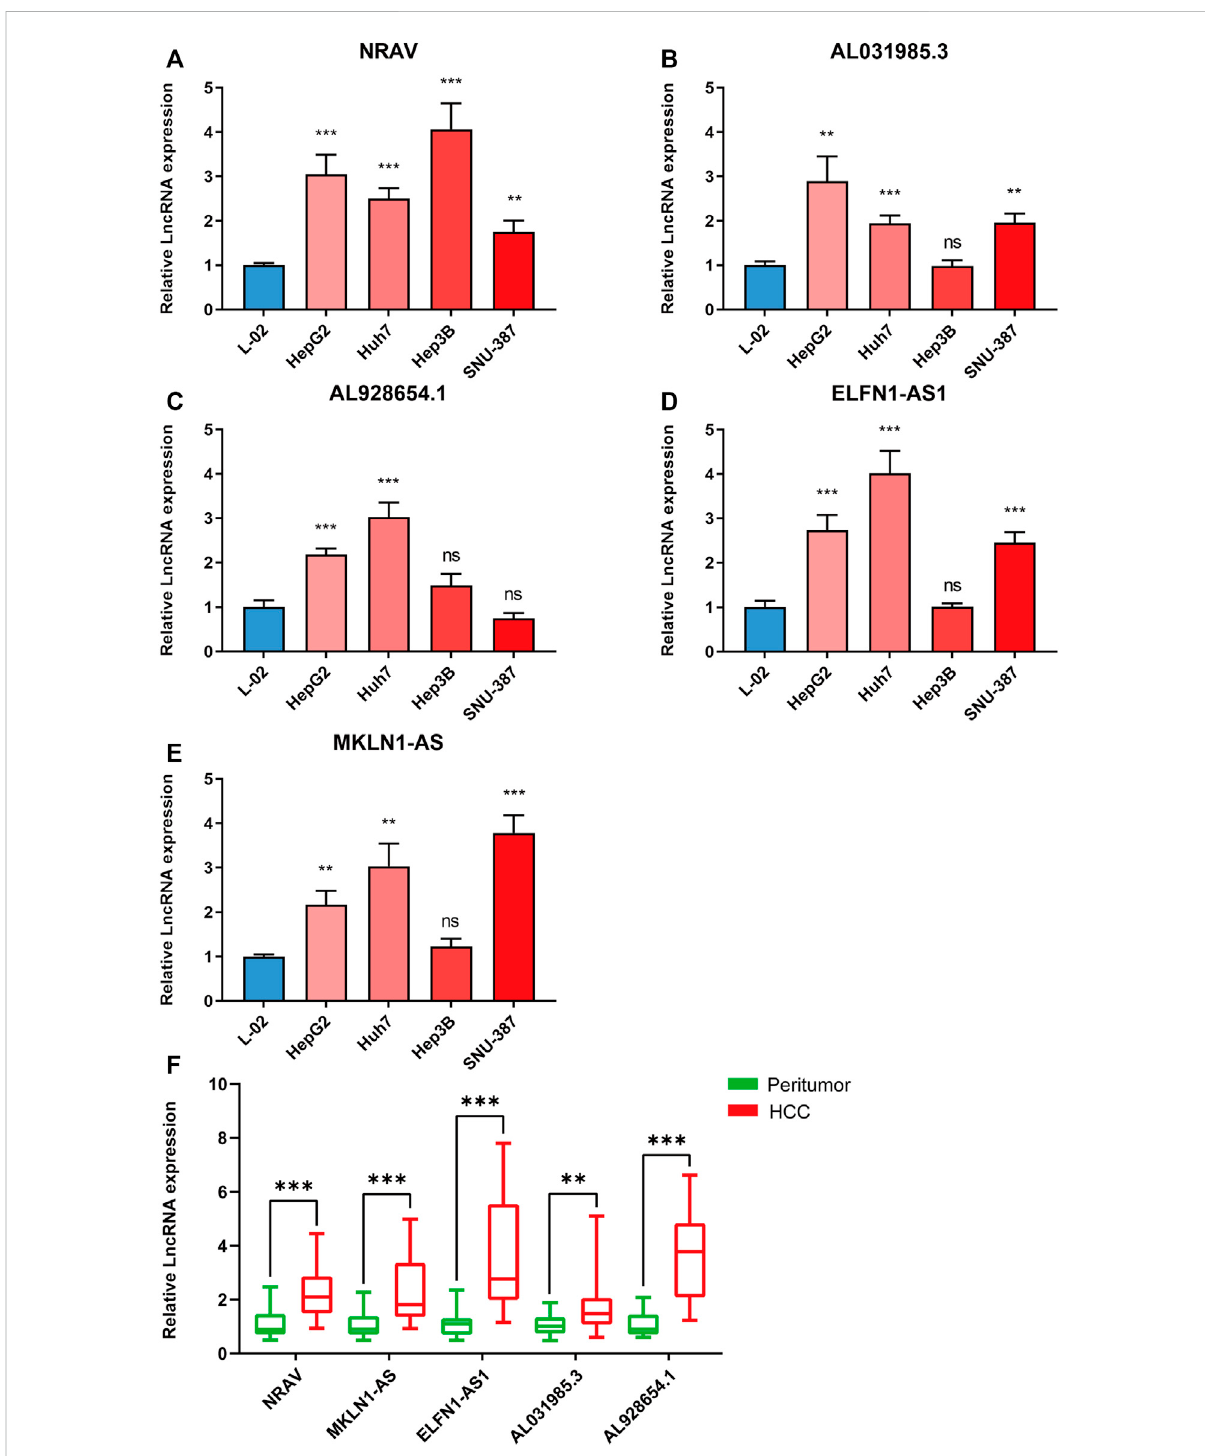
FIGURE 7 Validating theexpressionlevels of fi vem5C-related lncRNAs. Theexpression levelsofm5C-relatedlncRNAsin (A – E) 5cell linesand (F) 20pairs HCC tissues and paracancerous tissues. * p < 0.05, ** p < 0.01, and *** p <